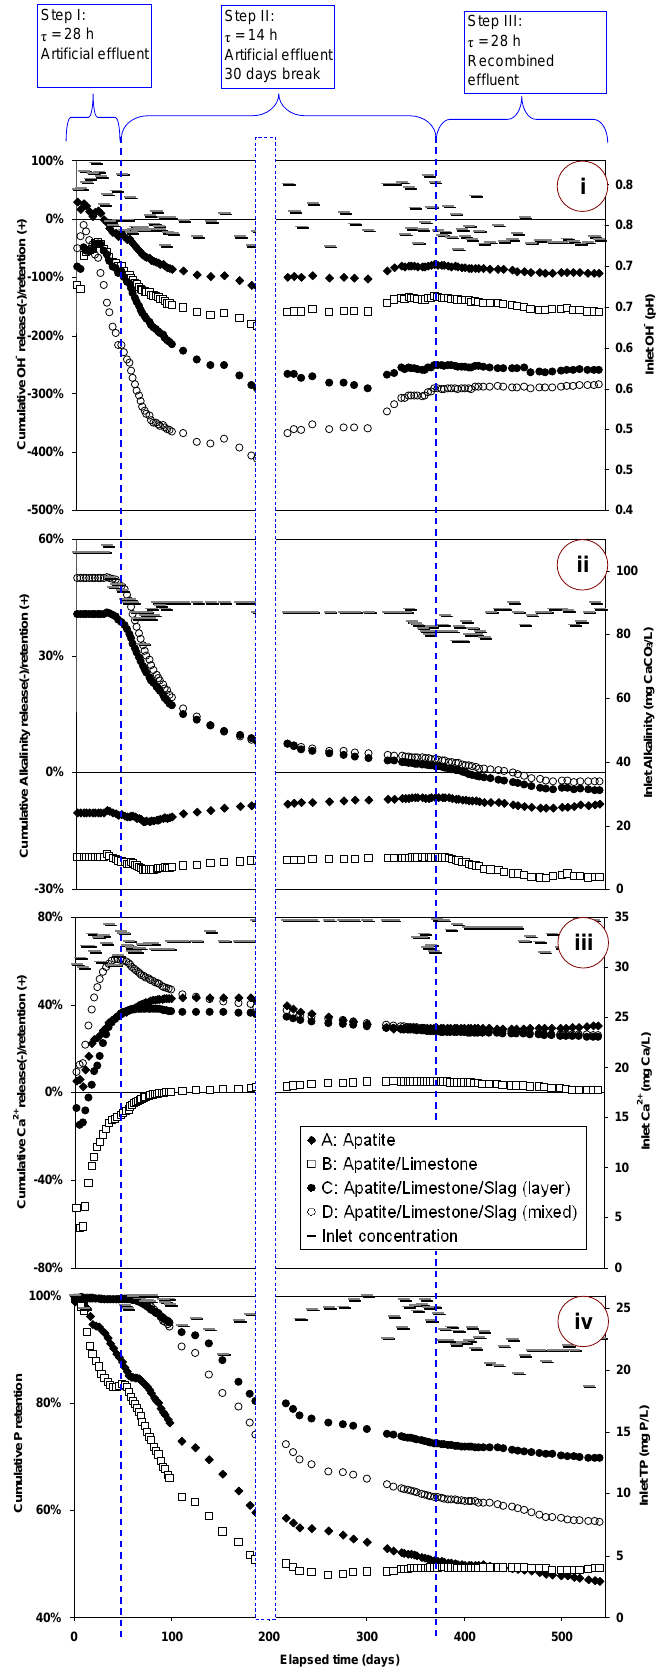
Figure 2. Evolution of inlet concentration (mg/L), pH and cumulative release/retention of (i): OH − , (ii): alkalinity, (iii): Ca 2+ , (iv):